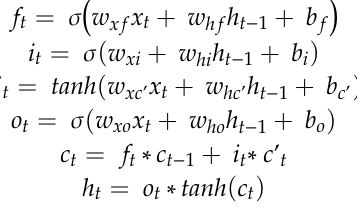
Figure 7. LSTM input data sample creation. ( a ) Data sampling for LSTM input ( 𝑤 = 3, ℎ = 2). ( b ) Representation of feature vector X and label Y.